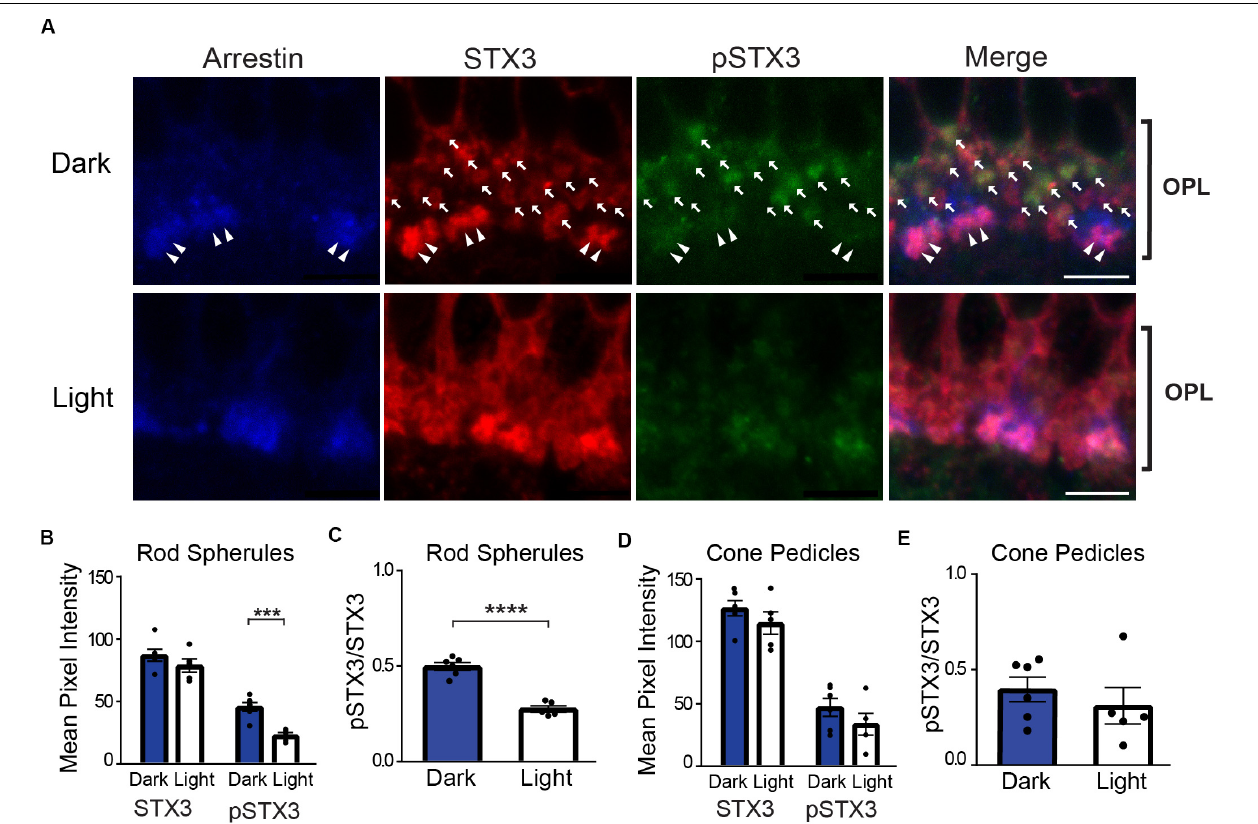
FIGURE 1 | In rod terminals, phosphorylation of STX3 at T14 is greater in dark-adapted mice than in light-exposed mice. (A) Top: A representative set of confocal images of a vertical section through the outer plexiform layer (OPL) of the retina of a dark-adapted mouse. Arrows mark the presumptive rod terminals in the image. Note that many of STX3-labeled rod terminals are also pSTX3 positive. Double arrowheads mark the arrestin-positive cone terminals. Bottom: A representative set of confocal images through the OPL of retina from a dark-adapted mouse exposed to a 15-min light stimulus. Note the relatively weak pSTX3 immunoreactivity. For upper and lower panels, retinal sections were triple-labeled for cone-arrestin (blue) to mark the cone terminals, STX3 (red), which labels both rod and cone terminals, and pSTX3 (green). Scale bar = 5 µ m. (B) Comparison of the mean pixel intensity of STX3 immunolabeling in rod terminals revealed no light/dark difference. By contrast, the mean pixel intensity of pSTX3 in rod terminals was significantly diminished in the light when compared to the dark ( p = 0.0006). (C) Quantification of the pSTX3 to STX3 ratio in rod terminals demonstrates that in the dark-adapted mouse (blue bars) the mean ratio of pSTX3 to STX3 is significantly greater than in the light-treated mouse (white bars). p < 0.0001. (D) There was no light/dark difference in the mean pixel intensity of STX3 immunolabeling in cone terminals and no clear light/dark difference in pSTX3 immunolabeling. (E) Quantification of the pSTX3 to STX3 ratio in cone terminals indicated a mean pSTX3 to STX3 ratio that is not significantly different between lighting conditions. p = 0.465. For (B–E) , n = 6,5 (mice). ***Indicates p < 0.001 and ****indicates p <